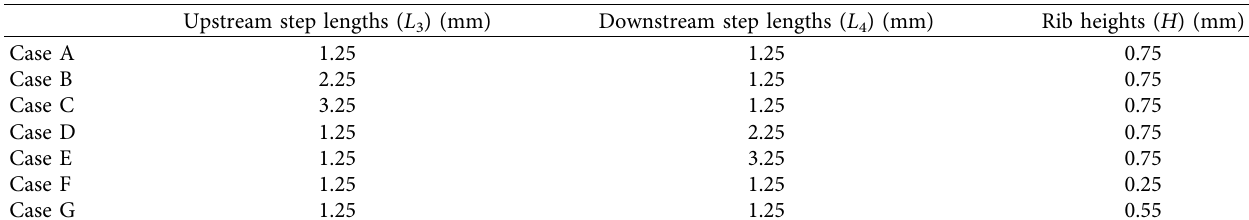
Table 1: The improved microcombustion chamber with various step lengths and rib